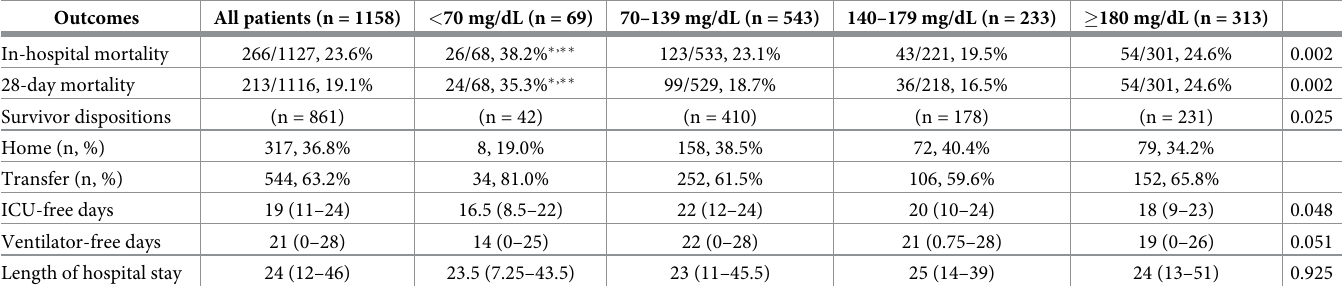
Table 2. Clinical outcomes and blood glucose on